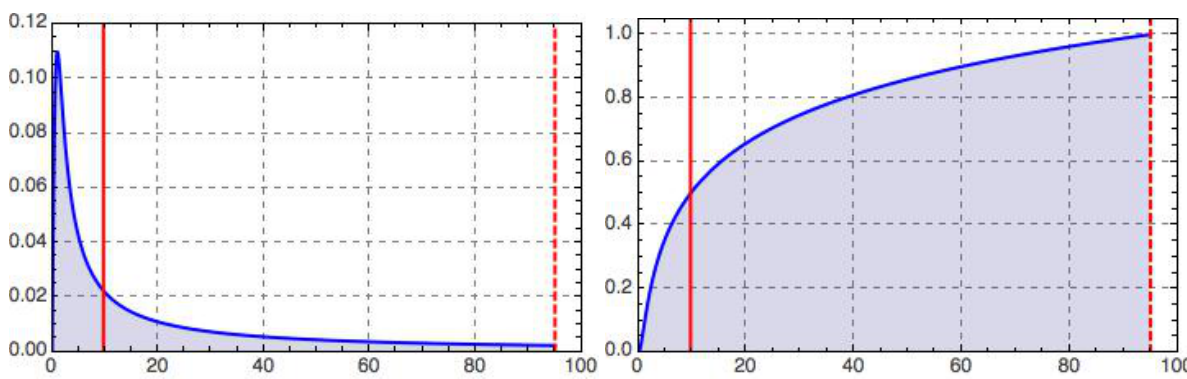
= 1 and marks the border + √ T , ≈ 1 √ 2 a R . With ≈ 1 2